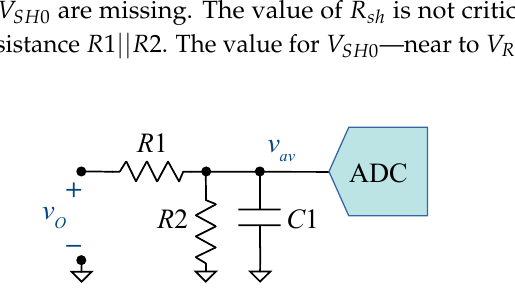
Figure 4. Acquisition chain for the inverter output voltage.